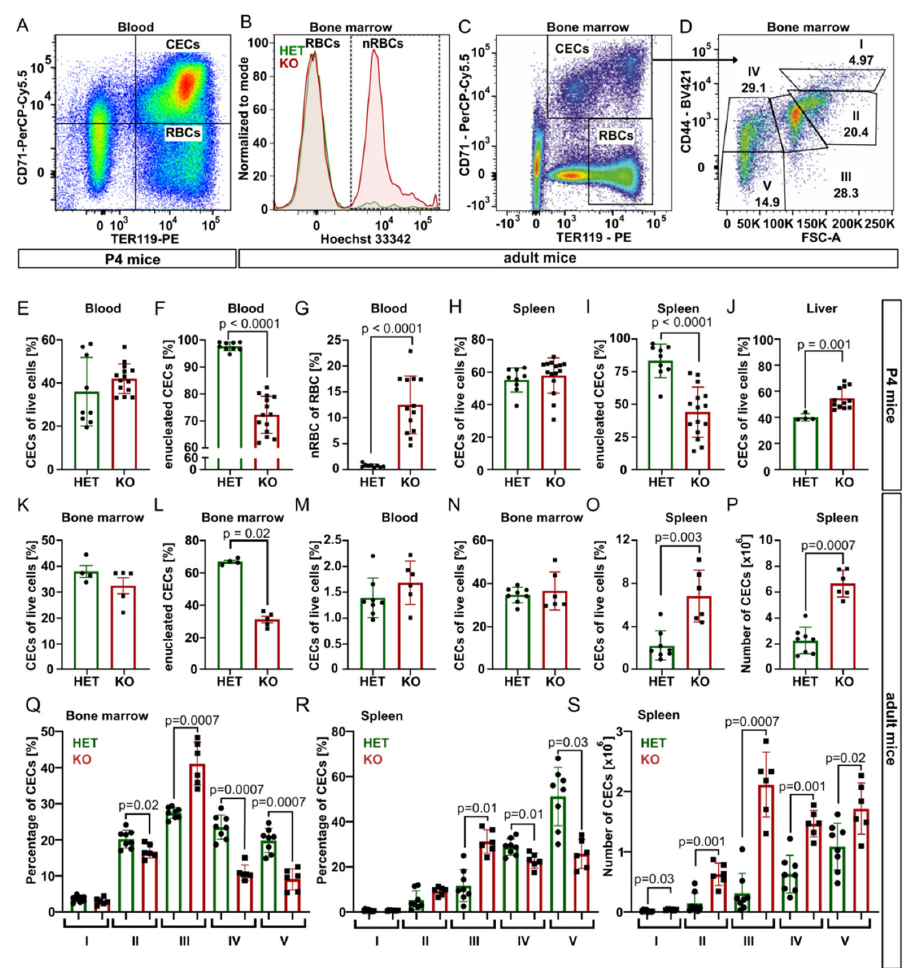
Figure 2. Flow cytometry analysis of CECs and RBCs. Experimental set ‐ up: ( A ) Gating of CECs and erythrocytes (RBCs). ( B ) Hoechst 33342 signal defines nRBCs. ( C ) Gating strategy, ( D ) maturation stages of CECs [14]. Results, pups (either sex): ( E – G ) abundance and enucleation status of CECs and nRBCs in blood (N HET = 9, N KO = 14); ( H , I ) spleen (N HET = 9, N KO = 15); ( J ) liver, non ‐ parenchymal (N HET = 4, N KO = 12). Adults (female): ( K , L ) bone marrow, young adult (N HET = 4, N KO = 5); (M–S) 7–8 months old (N HET = 8, N KO = 6); ( M ) blood; ( N ) bone marrow; ( O ) spleen; and ( P ) absolute number of CECs in spleen. Maturation of CECs: percentage of different immature stages in the ( Q ) bone marrow and ( R ) the spleen and ( S ) absolute numbers in the spleen: proerythroblasts (I), basophilic (II), polychromatic (III), orthochromatic (IV), and reticulocytes (V). p ‐ values by Mann–Whitney test.